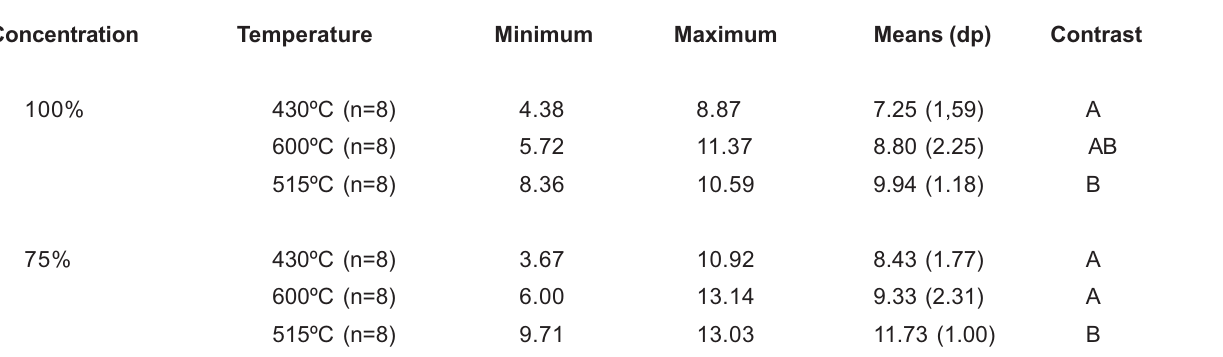
Different letters indicate statistically significant difference at